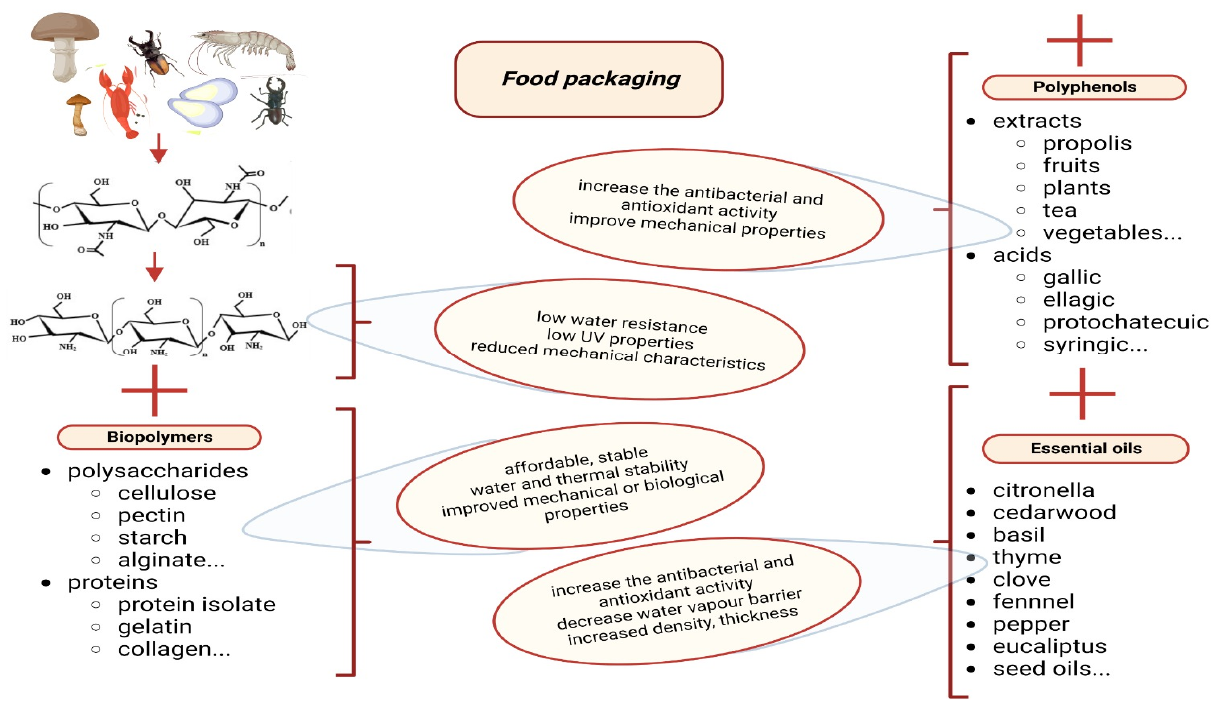
Figure 4. Schematic representation of chitosan matrix incorporating functional materials for improv- ing the characteristics of the composite